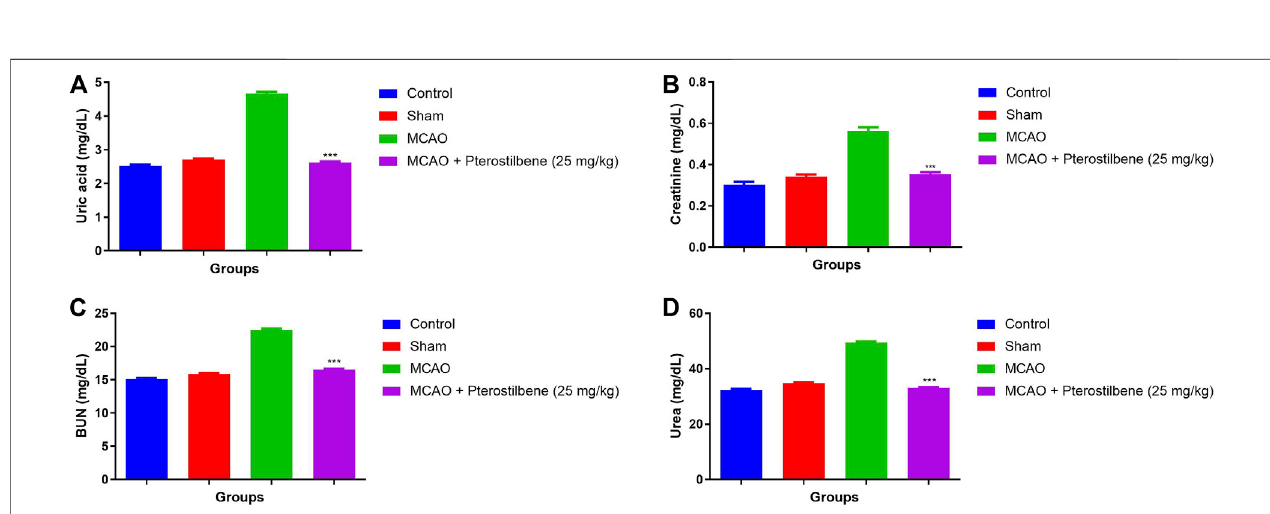
FIGURE6| showedtherenalparametersofamongexperimentalgroups. (A) uricacid, (B) creatinine, (C) BUNand (D) urea.Valuesareexpressedasmean ± SEM. The t -test was used for the signi fi cant difference between groups: * p < 0.05, ** p < 0.01, *** p < 0.005. NS, non-signi fi cant.